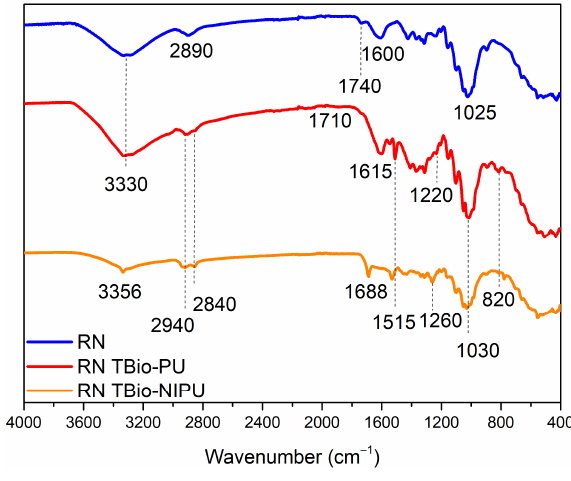
Figure 8. FTIR spectra of impregnated natural ramie.